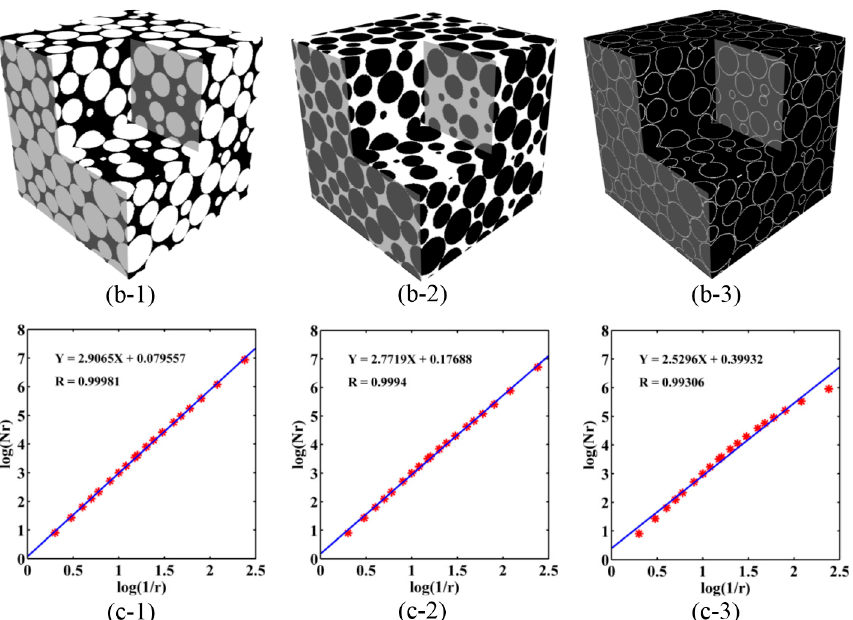
Figure 2. The calculation process of different fractal phases in digital 3D core. ( a ) Digital core model; The phases of interest are ( b-1 ) skeleton, ( b-2 ) pore, and ( b-3 ) surface; The calculated results correspond to ( c-1 ) skeleton fractal dimension, ( c-2 ) pore fractal dimension, and ( c-3 ) surface fractal dimension.